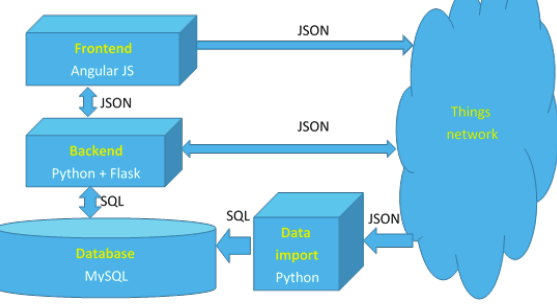
Fig. 5. The interconnections of software